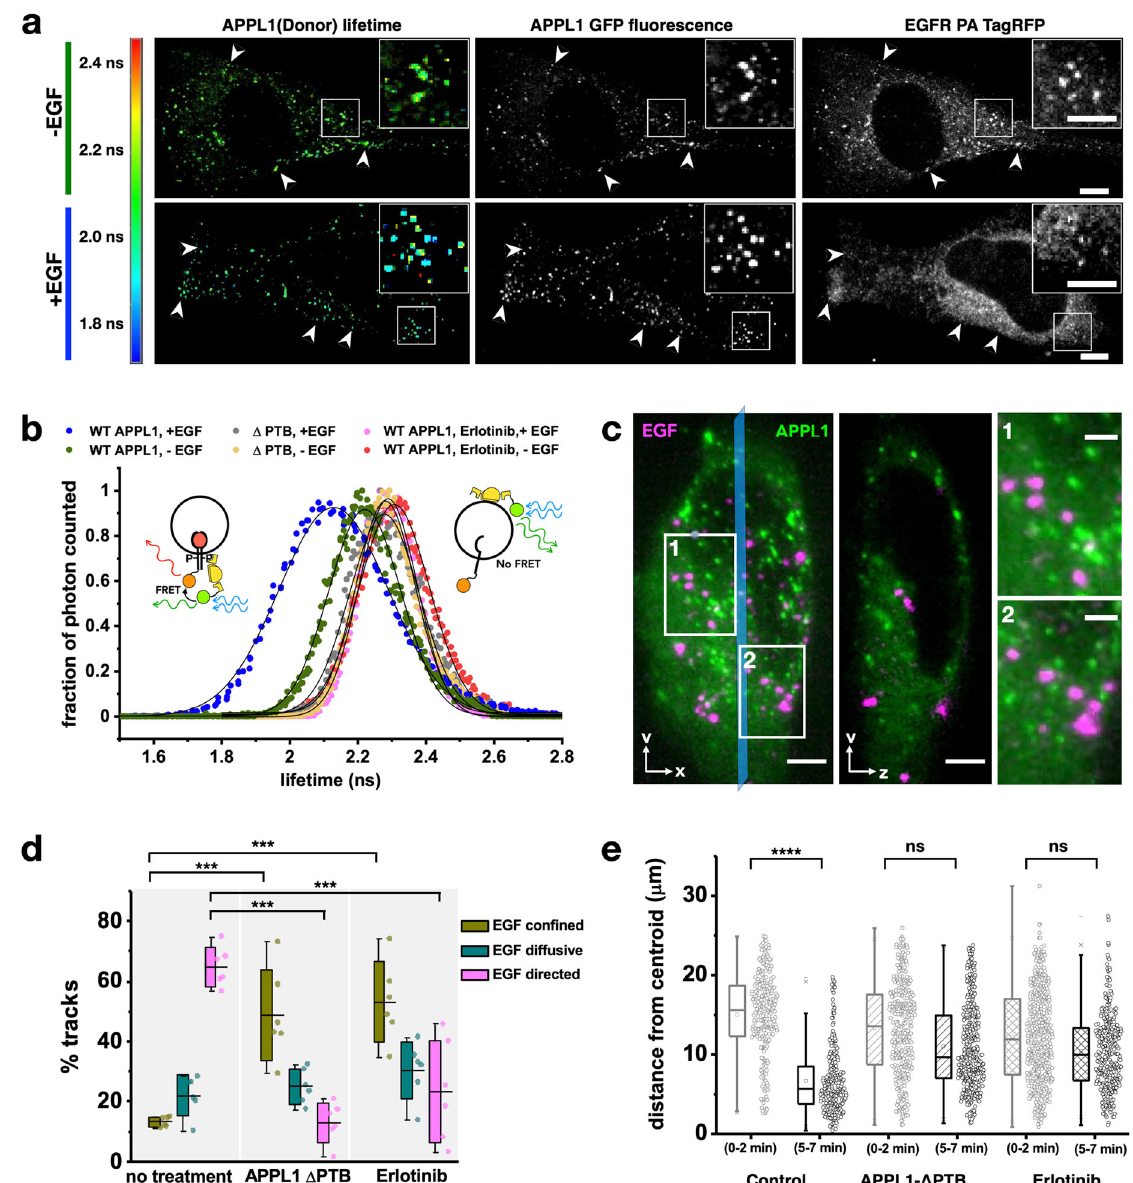
Fig. 5 APPL1 binds activated EGFR via its PTB domain to mediate minus-directed motility. a Representative images of FLIM-FRET experiments of HeLa cells transfected with APPL1-EGFP and EGFR-PA-TagRFP, in an unstimulated state and 2 min post 100 nM EGF addition. Colored scale bar represents donor fl uorescence lifetime ranging from 1.7 ns (blue) to 2.5 ns (red). Left panels display FLIM image of APPL1 EGFP (donor), center panels display fl uorescence image of APPL1 EGFP and right panels display fl uorescence image of EGFR-PA-TagRFP. Arrows indicate APPL1-EGFR colocalizing endosomes in all channels, box indicates the region of zoomed inset. Scale bar = 2 μ m. b Fluorescence lifetimes distribution of APPL1-EGFP photons in unstimulated cells; wild-type APPL1 (green), wild-type APPL1 + erlotinib (orange) and APPL1 Δ PTB (yellow). As well as 2 min post 100 nM EGF stimulation in wild-type APPL1 (blue), wild-type APPL1 + erlotinib (pink) and APPL1 Δ PTB (gray). Black curves represent a Gaussian fi t ( n = 8 cells, plot data consists of values from ~400 endosomes for each condition). c Representative images of WT-APPL1-GFP (green) in HeLa cells pre-treated with 10 μ M erlotinib and stimulated with 100 nM EGF-647 (magenta). Left panel displays a maximum intensity projection (MIP). Center panel displays a cross-sectional slice (YZ view) corresponding to the blue line. No colocalization is observed between EGF and APPL1. Scale bar = 5 µ m. Right panels show zoomed regions 1 and 2 from the XY MIP, respectively. Scale bar = 2.5 µ m. d Percentage of EGF-bearing endosome tracks which showed con fi ned (green), diffusive (teal), or directed (magenta) motility in HeLa cells transfected with APPL1- Δ PTB EGFP or treated with 10 µ M erlotinib. Error bars correspond to the standard deviation ( n = 6 cells). e Scatter plots of EGF distance in microns from centroid in HeLa cells treated with 100 nM EGF at 0 – 2 and 5 – 7 min post addition as described in Fig. 1k. The Hela cells were either transfected with APPL1- Δ PTB EGFP (diagonal lined plot) or treated with 10 µ M erlotinib (crossed plot) ( n = 10 cells). The inner box of the box plot represents the standard deviation, the inner bar the median and the dot the mean, the ‘ x ’ represents the counts within 1 – 99% of the sample and the horizontal bars the range. Statistical signi fi cance of the difference of the means was evaluated using an unpaired t -test, *** represents p < 0.0001, ** represents p <